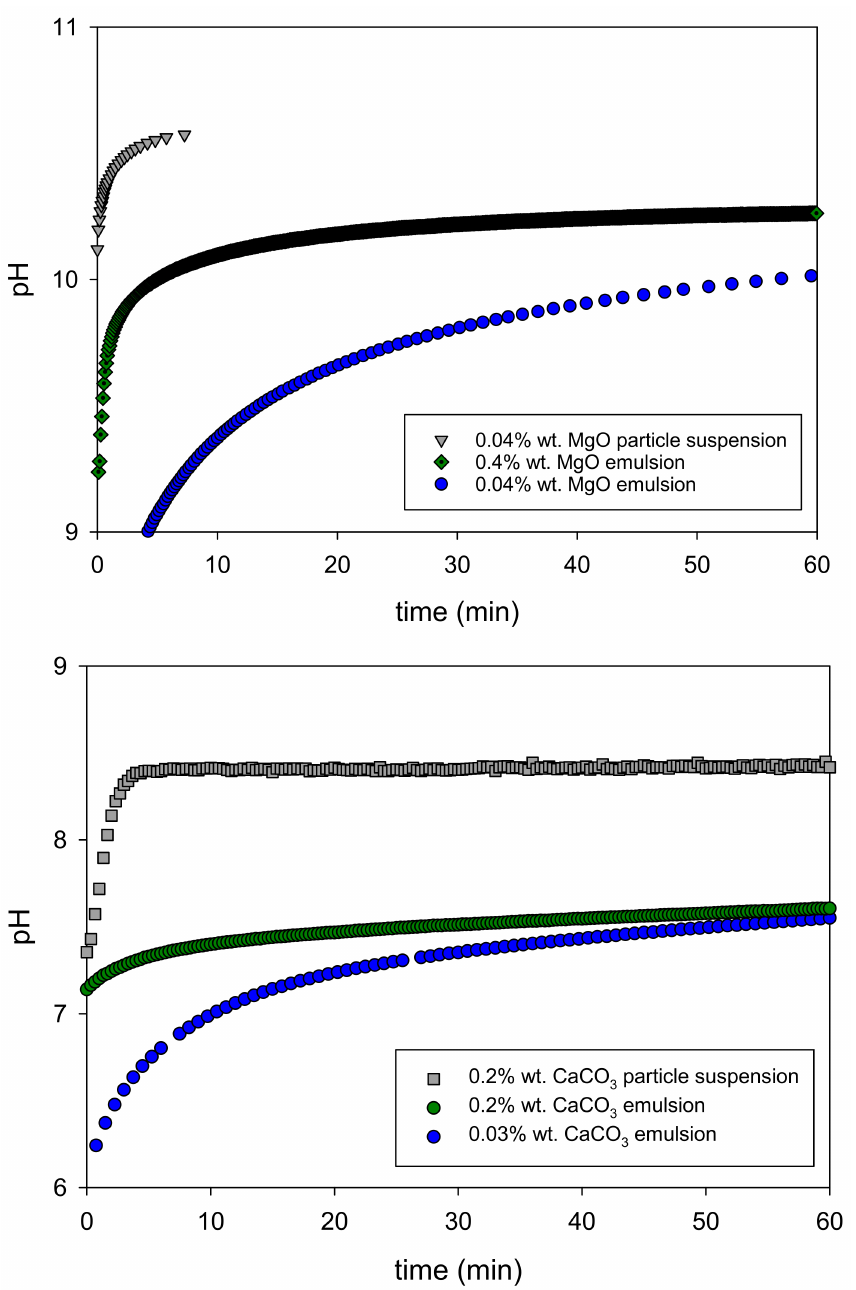
Figure 3. Illustrative pH rebound curves measured after HCl acid addition from particle suspensions and emulsions with varying mass loadings for ( top ) MgO and ( bottom ) CaCO 3 . Note that the temporal resolution of the data gives the illusion of a line, but all information shown in this figure is in the form of discrete